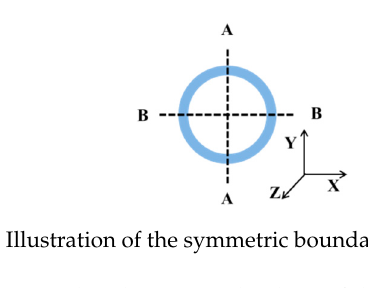
Figure 15. Illustration of the symmetric boundary conditions of stent.